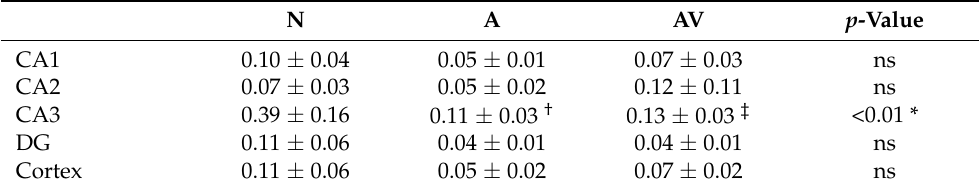
Figure 3. TUNEL positivity in ApoE4-KI mice after auditory and audiovisual stimulation. ( a ) TUNEL positive areas; ( b ) TUNEL positivity in the hippocampal CA3 region. † statistically significant difference in the hippocampal CA3 region between the A and N groups ( p < 0.05); ‡ statistically significant difference in the hippocampal CA3 region between the AV and N groups ( p < 0.05). TUNEL, terminal-deoxynucleotidyl transferase mediated nick end labeling; CA, cornu ammonis; DG, dentate gyrus; N, no stimulation ( n = 5); A, auditory stimulation ( n = 10); AV, audiovisual stimulation ( n = 10). Eight different tissue slices were used as section replicates, and technical replicates from a single mouse were performed twice. Table 3. TUNEL positivity in ApoE4-KI mice after auditory and audiovisual stimulation.